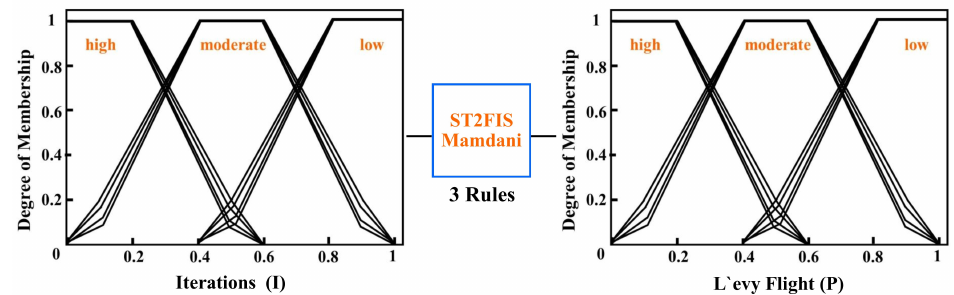
Figure 7. Dynamic parameter adaption of fuzzy CS algorithm using ST2FIS.